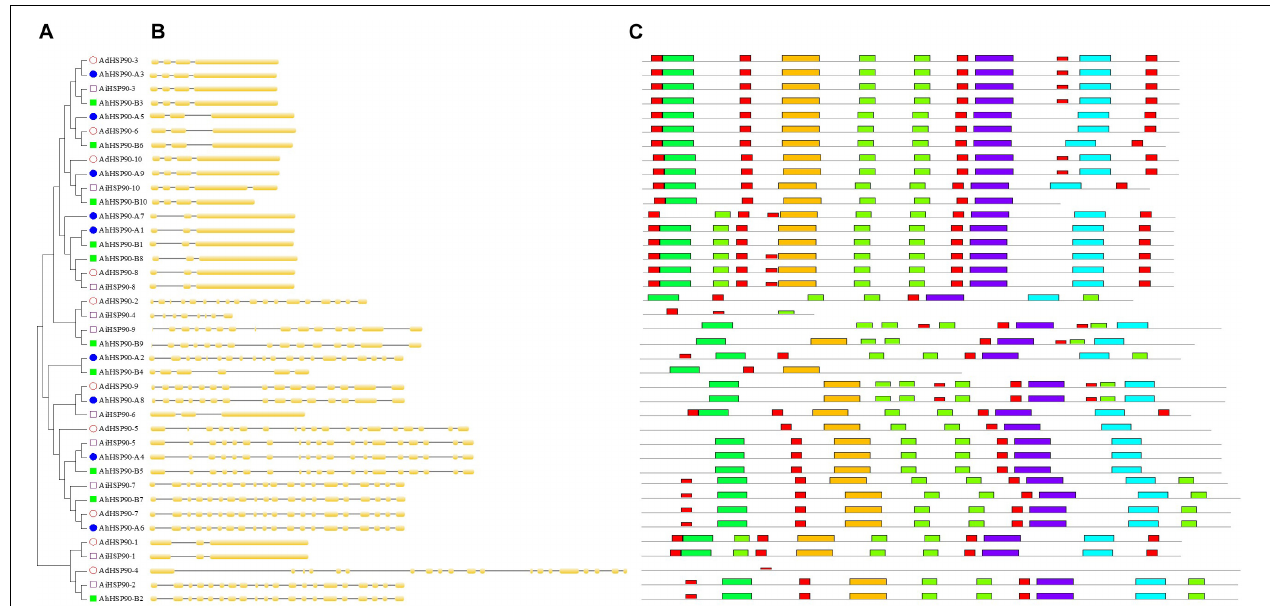
FIGURE 4 | Phylogenetic analysis, gene structures, and conserved motifs of Arachis HSP90 genes. (A) Phylogenetic tree of Arachis HSP90s. (B) Exon-intron structure of Arachis HSP90 genes. (C) Ten conserved motifs in HSP90 proteins.